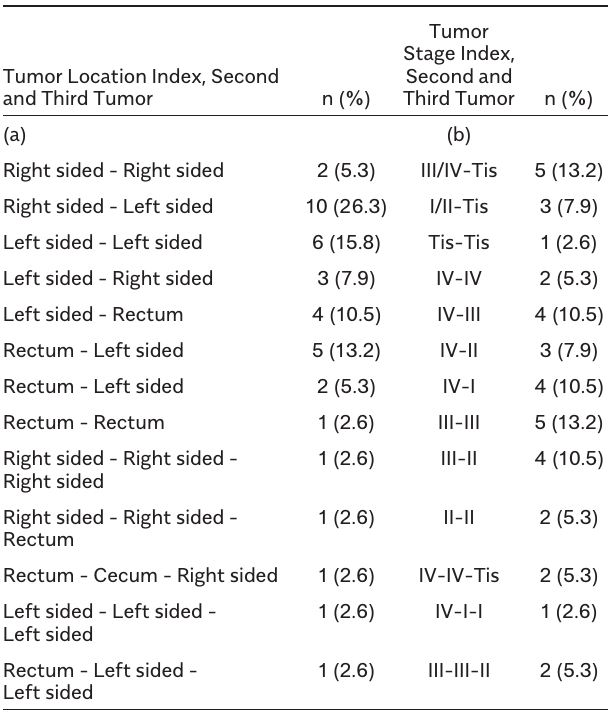
Table 1. Anatomical (a) Distribution and Stage (b) of First, Second, and Third Tumors in Patients with SCRCs (n = 38)